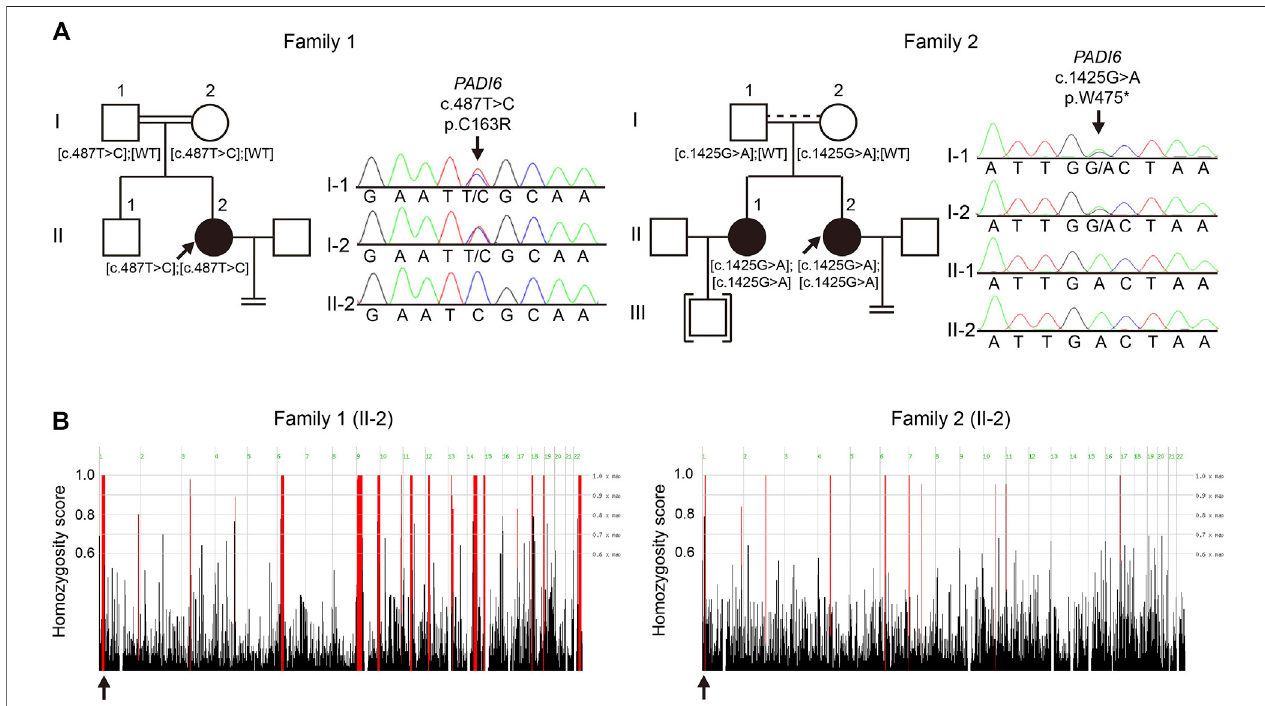
FIGURE 1 | Identi fi cation of novel PADI6 variants in two Chinese families with early embryonic arrest. (A) Pedigrees and Sanger sequencing results of the families. Black solid circles denote the patients; black arrows denote probands ofthe families. Brackets denote adoption, equal signs indicate infertility. Parallel double solid lines represent consanguinity; parallel solid line with dash line represent suspected consanguinity. (B) Homozygosity mapping of the probands in two families. Homozygous regions are indicated in red, and the black arrows indicate the location of PADI6 .